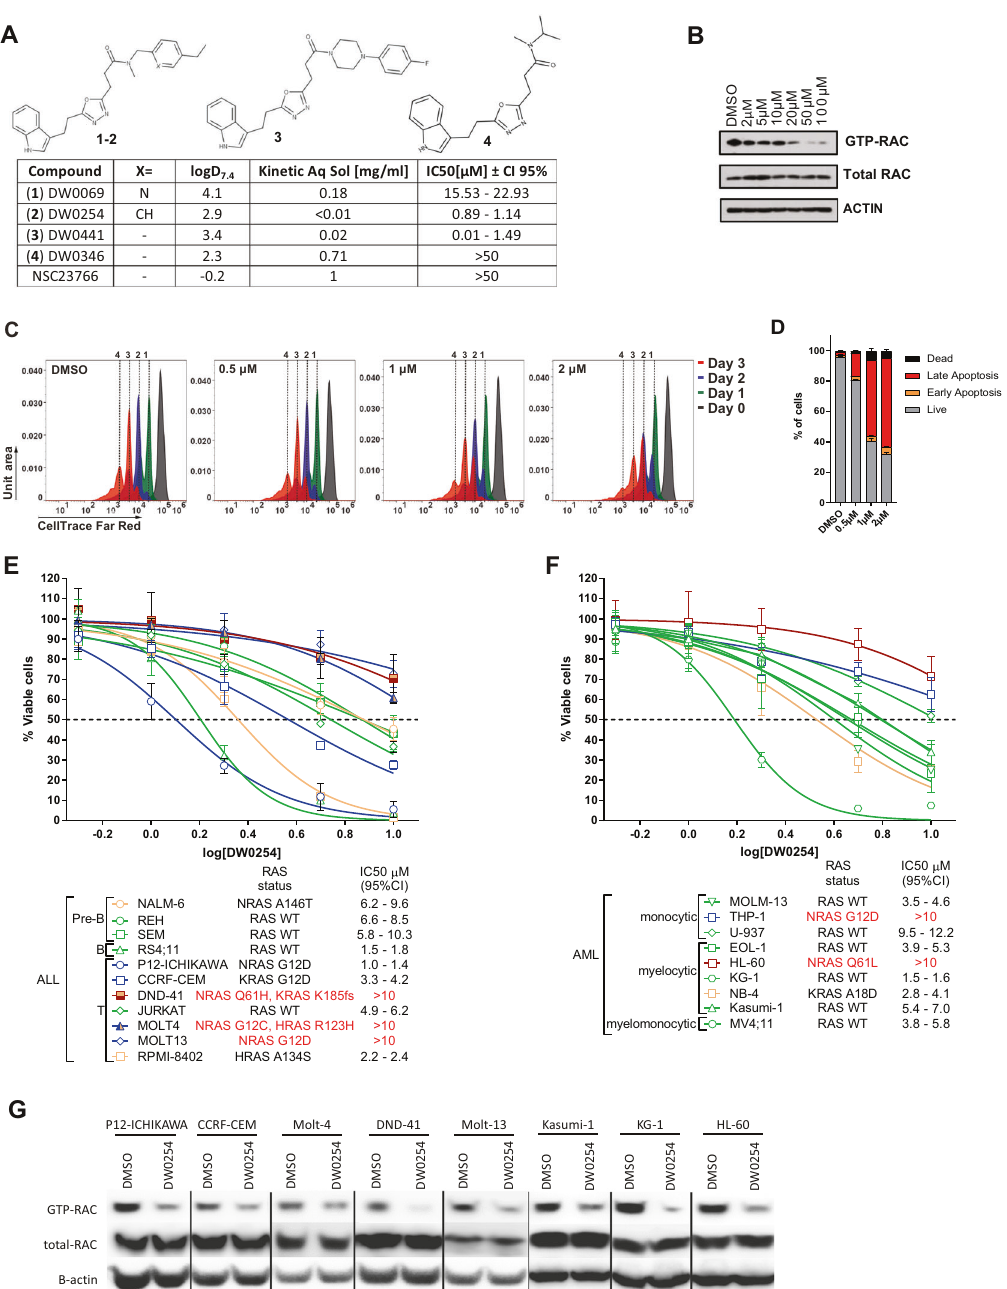
Fig. 2 Compound DW0254 inhibits RAC activation and shows anti-leukemic activity in vitro in leukemia cell lines. A Chemical structure, physicochemical properties, and biological activities cell line for compounds 1 – 4 and NSC23766 (structure not shown), a known inhibitor of RAC. IC 50 values represent the dose at which 50% cell viability was achieved on P12-ICHIKAWA cells. B GTP-RAC activity inhibition in P12- ICHIKAWA cells treated with different doses of DW0254 for 3 h. GST pulldown assays were conducted by incubating lysates with PAK1-PBD beads. Cell lysates to detect total RAC and proteins eluted from the PAK1-PBD beads to detect GTP-RAC were subjected to Western blotting using anti-RAC (610651, BD Transduction laboratories, San Jose, CA) and anti-beta ACTIN (A5441, Sigma-Aldrich) antibodies. Data are representative of three individual experiments. C Representative peaks of Far Red CellTrace staining of P12-ICHIKAWA cells treated with different doses of DW0254 and examined by FACS on three consecutive days. Peaks 1 – 4 represent the number of times the cells in each peak have divided; data shown from one of the three independent experiments. D Bar graph showing percentage of apoptosis by AnnV/PI staining of P12-ICHIKAWA cells treated for 3 days with different doses of DW0254, data represent mean ± SD of two independent experiments with n = 3 samples for each condition. Live: AnnV − /PI − ; Early apoptosis: AnnV + /PI − ; Late apoptosis: AnnV + /PI + ; and Dead: AnnV − /PI + . E Drug dosage curve showing live cell viability assay after 3 days of DW0254 treatment of human ALL and F AML cell lines with diverse backgrounds and RAS status as described, n = 4 at each dosage, data show mean ± SD, one of three individual experiments showing the consistent results. Color code: WT RAS green, G12 mutant RAS blue, Q61 mutant RAS burgundy, other RAS mutations yellow. G GTP-RAC activity inhibition in a panel of T-ALL and AML cell lines treated with 50 µM DW0254 for 1